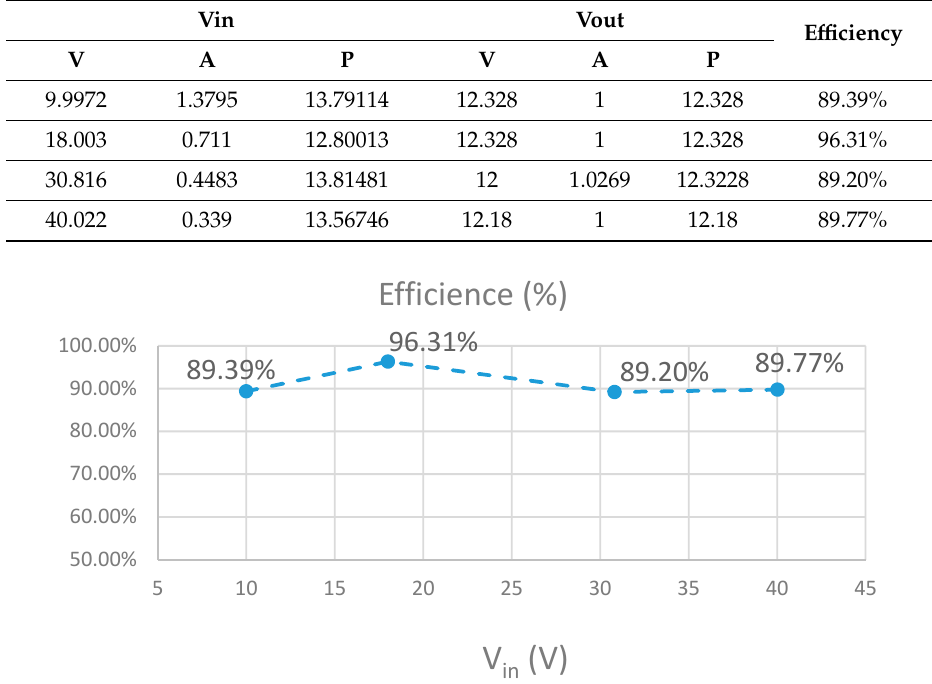
Figure 21. Waveforms of switch V GS and V DS with input of 40 V and output of 12 V / 1 A. (CH1, V GS 1 ; CH2, V DS 1 ; CH3, V GS 2 ; CH4, V DS 2 ). Table 3. Measured data of circuit.